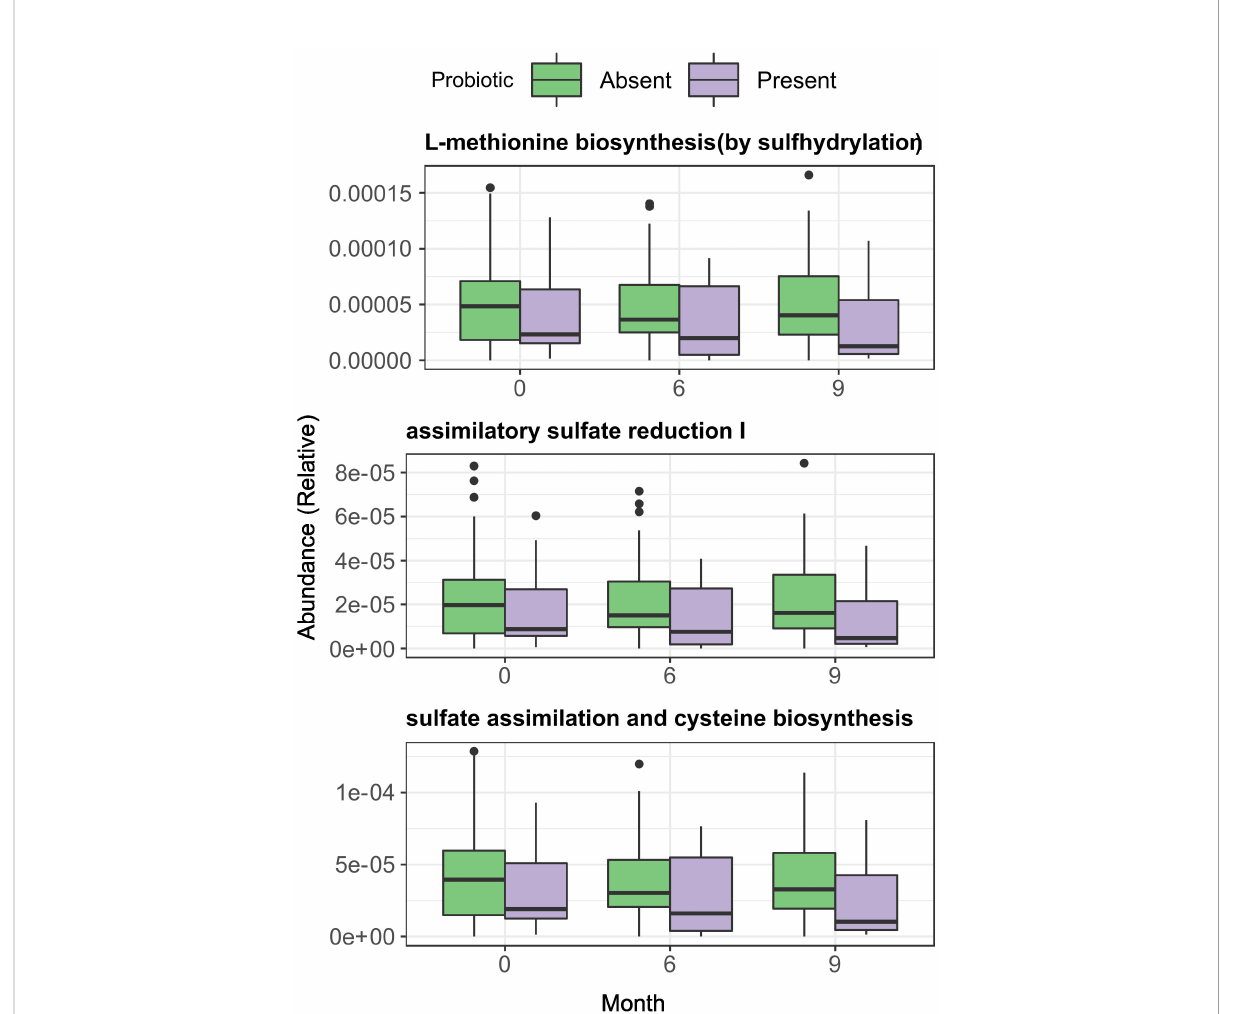
FIGURE 8 Longitudinal and across-group comparisons of Assimilatory Sulphate Reduction and sulphur amino acid pathways across intervention groups. Comparisons were performed across between groups by Wilcoxon test and longitudinally within-group with paired Wilcoxon